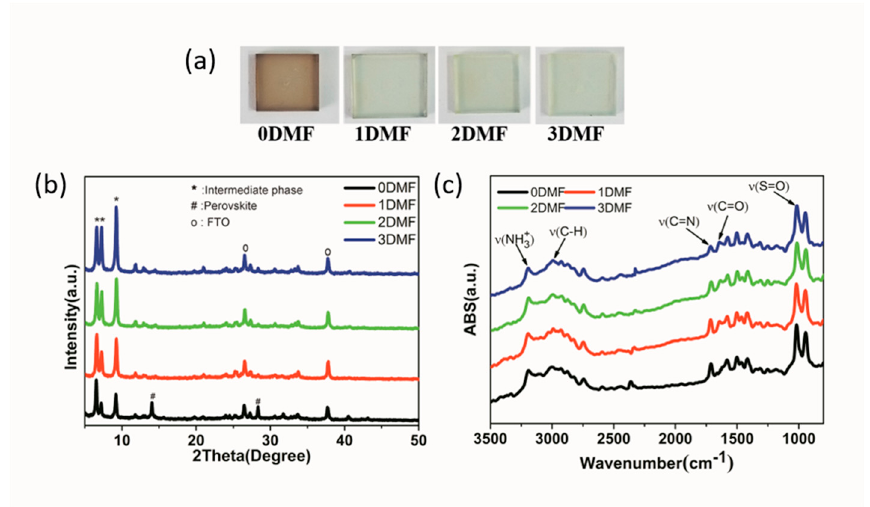
Figure 3. ( a ) The intermediate film photos of different precursors; ( b ) the X-ray diffraction (XRD) patterns and ( c ) Attenuated Total Reflectance Fourier Transform Infrared (ATR-FTIR) spectra of intermediate films.